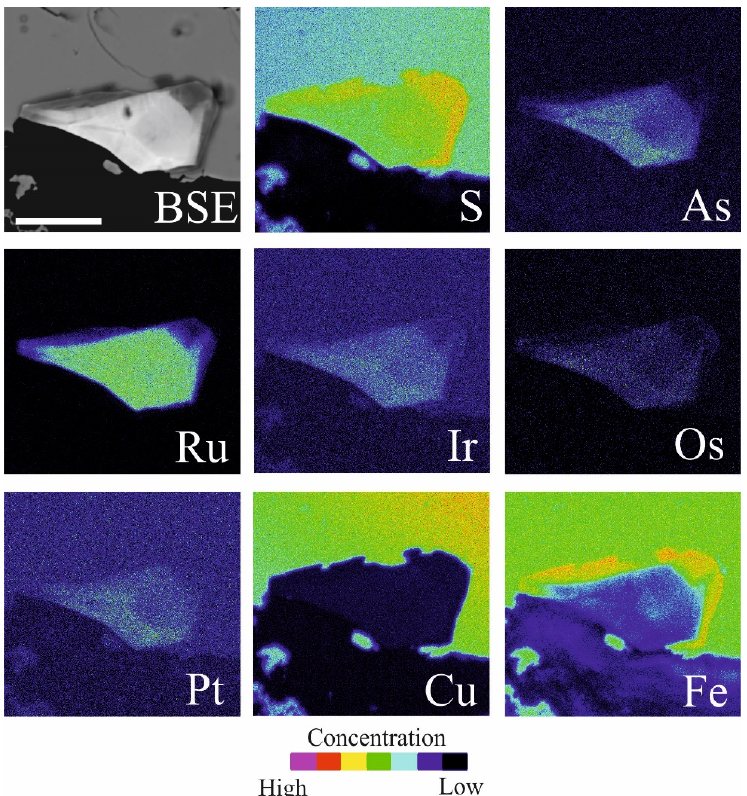
Figure 8. BSE image and X-ray element-distribution maps of S, As, Ru, Ir, Os, Pt, Cu, and Fe, showing the zoning of the laurite from the Merensky Reef, see reflected-light image of Figure 4C for the mineralogical assemblage. Scale bar is 20 µm.